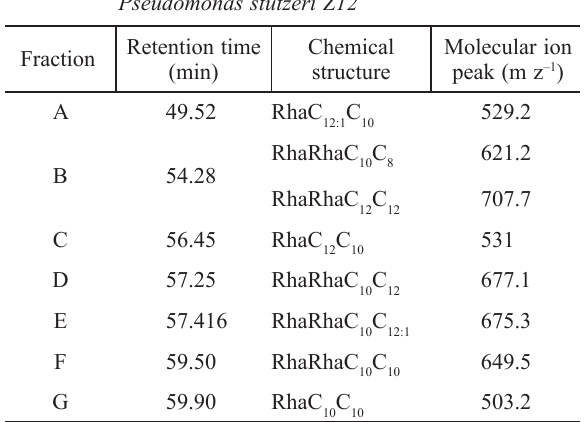
Table 4 – Chemical structure of rhamnolipids produced by Pseudomonas stutzeri Z12